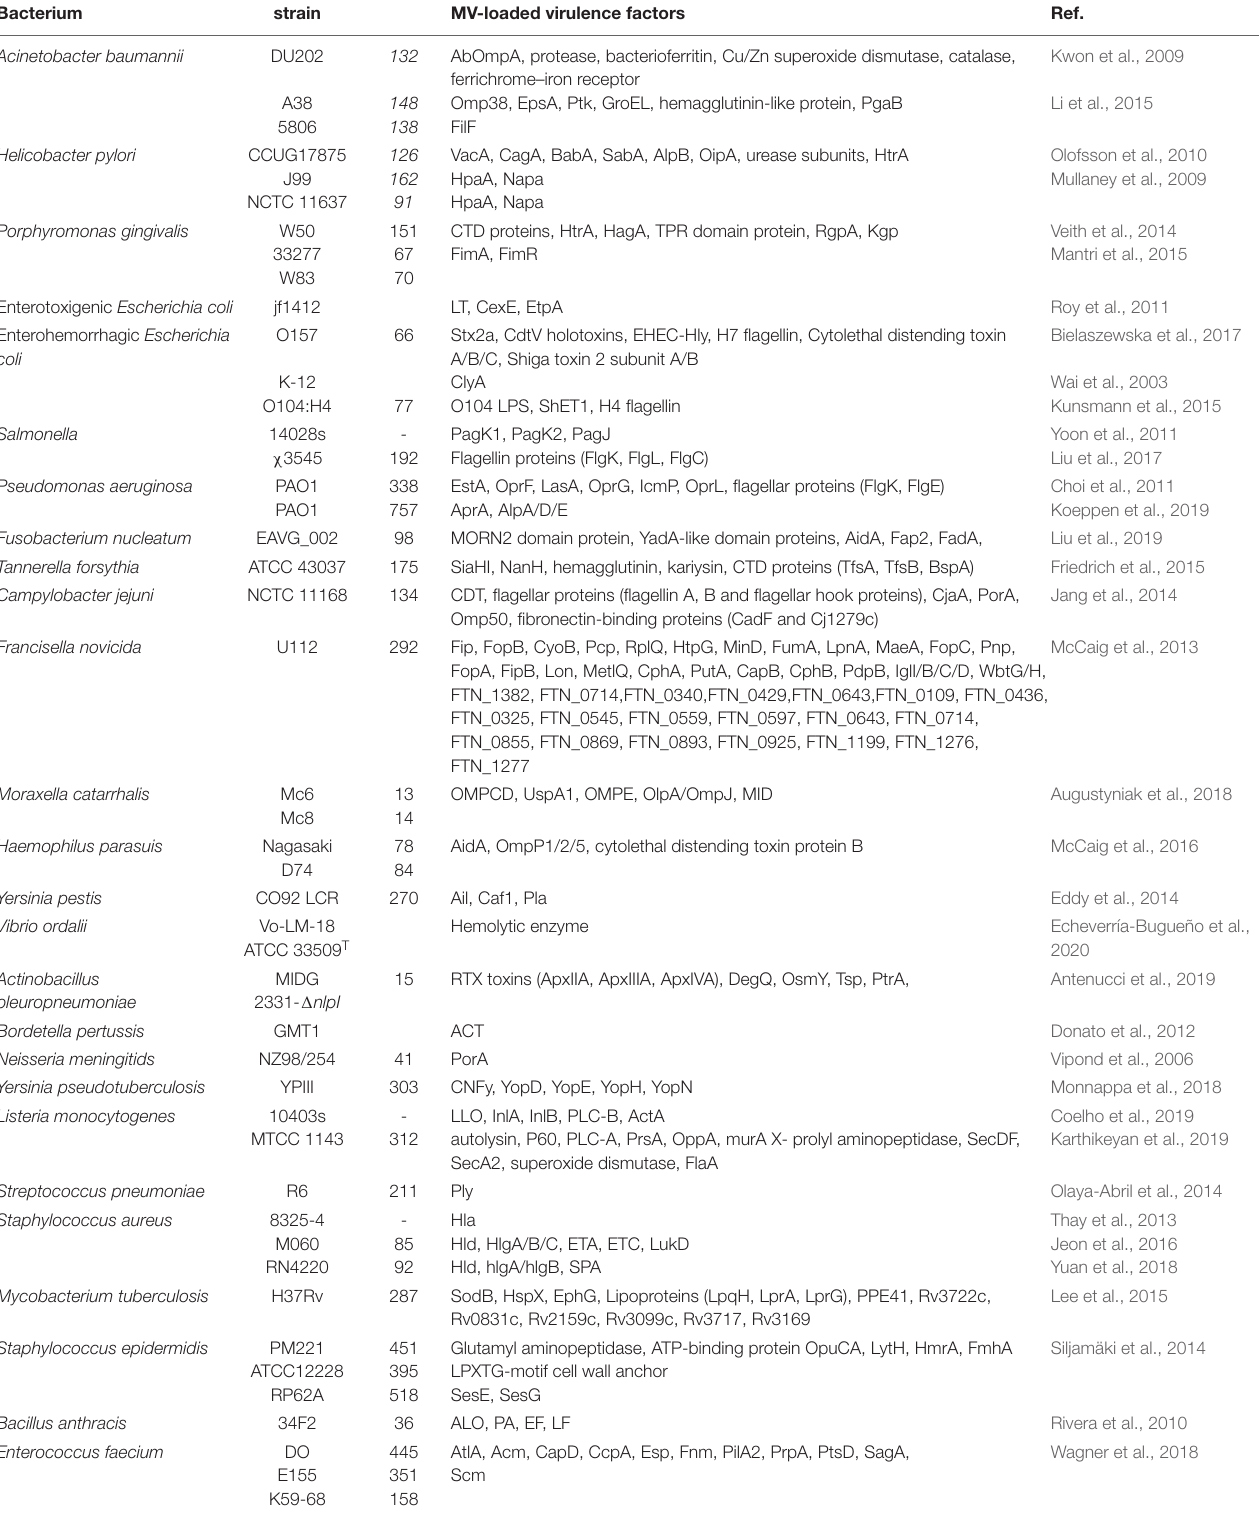
TABLE 1 | Bacterial virulence factors detected in